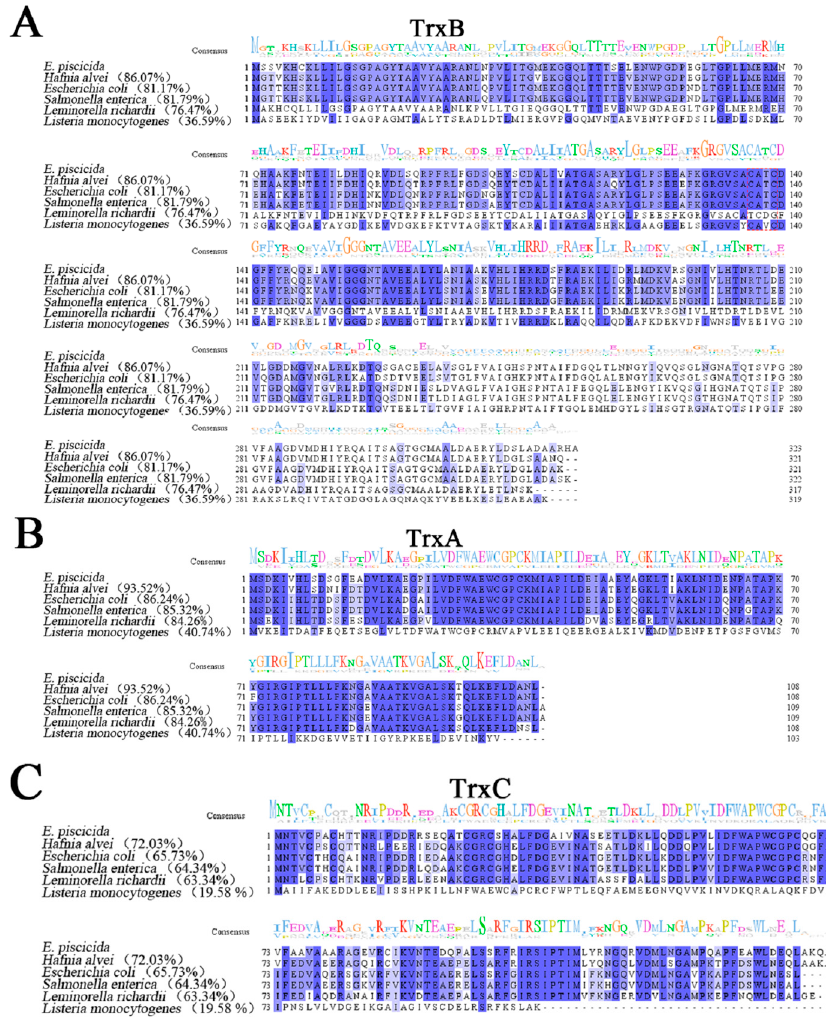
Figure 1. Multiple sequence alignments of TrxB ( A ), TrxA ( B ), and TrxC ( C ) with their